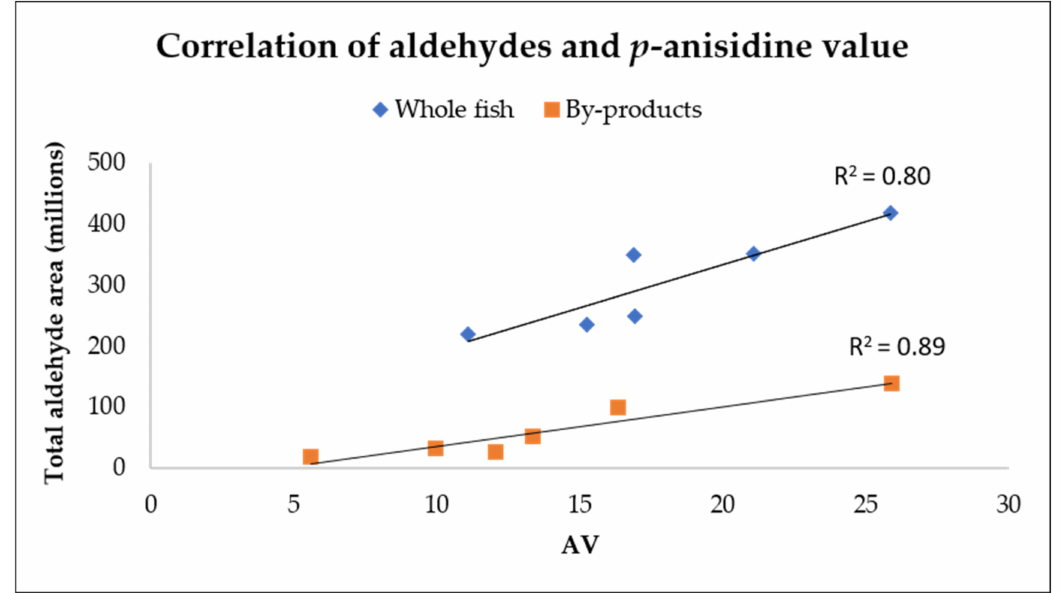
Figure 2. The correlation between p -anisidine value (AV) and total area of all identified aldehydes from the volatile analysis of enzymatically extracted oils from whole fish (blue) and by-products (orange) of Baltic herring. The scores plot for PC1 and PC2 from oils extracted from by-products (Figure A2a) show that Alcalase samples separate well from Neutrase and Protamex samples. PC1 and PC2 explain 87% of the variance in the dataset. PC1 seems to relate to the differences between the enzymes, whereas PC2 show no clear trend in treatment time or other known factors. The correlation loadings (Figure A2b) show that most volatiles group on the negative side of the Y-axis, whereas 2-methylbutanal is the only volatile with a significant effect on the positive side. 2-Methylbutanal has a negative correlation with heptane and 2,3-butanedione. Butanal is also located on the positive side of the Y-axis, but it